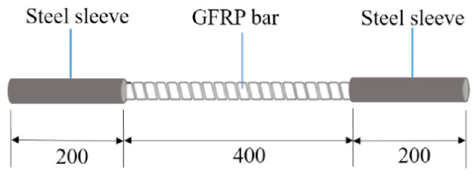
Figure 1. Test specimen [mm].